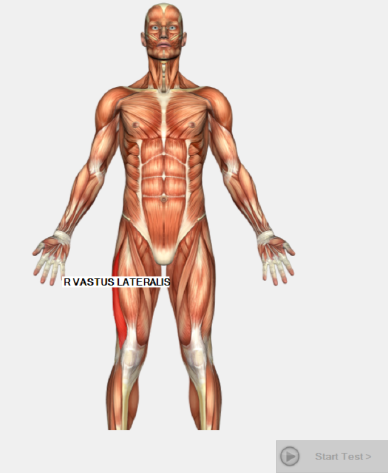
Figure 1. The vastus lateralis muscle.